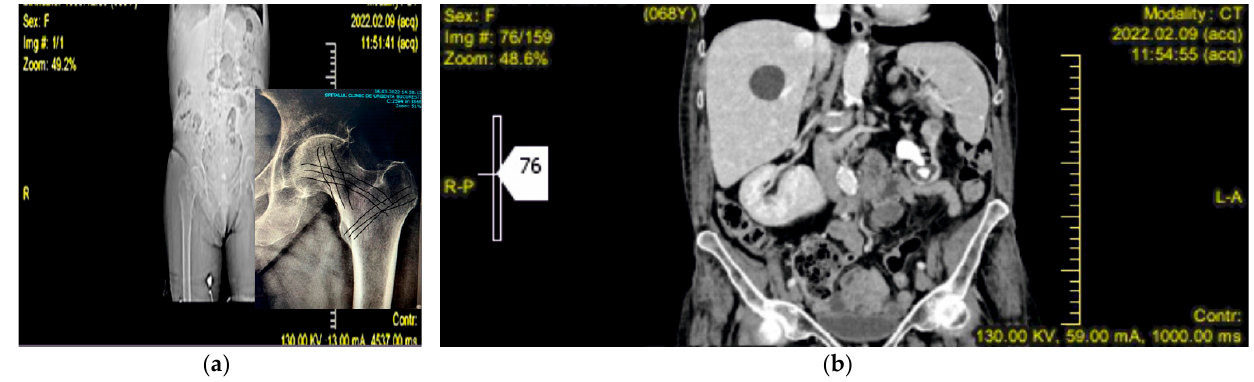
Figure 1. Case 1. ( a ) X-ray radiograph with inset showing the trabeculae of the femoral neck; ( b ) CT before fracture.